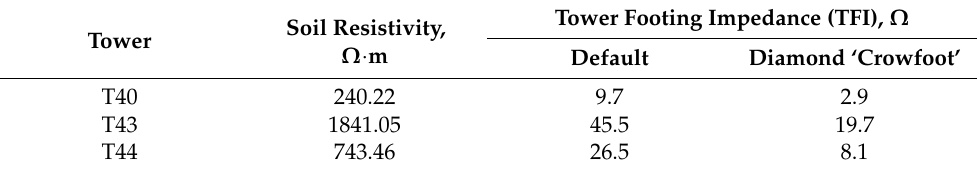
Table 7. Tower footing impedance value for soil resistivity variations before and after improvement.